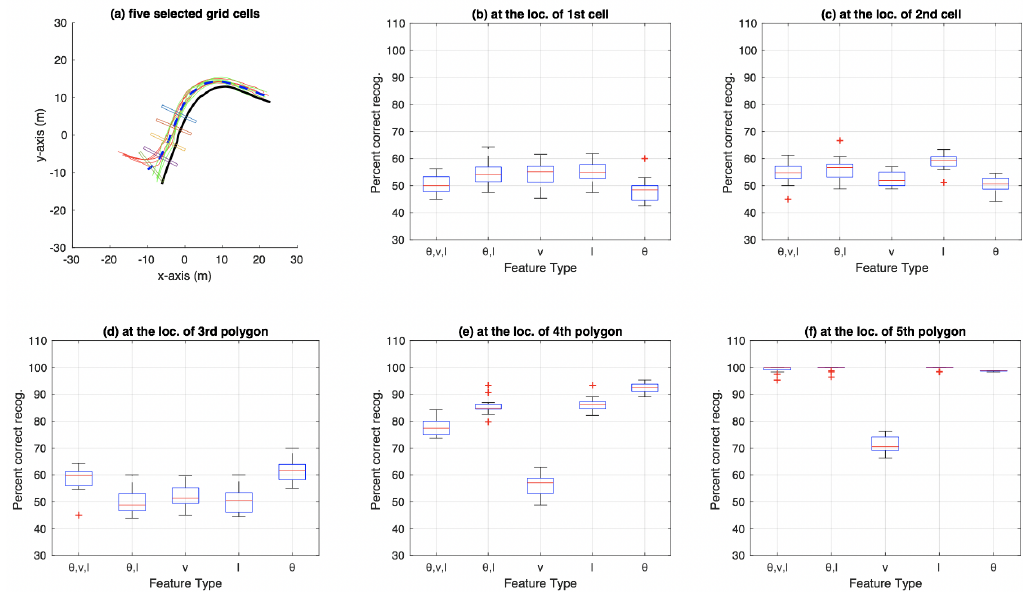
Figure 7. Aggregate results for bicycle dataset using particle filtering: ( a ) the five grid cells show locations where 60%, 70%, 80%, 90%, and 99% of the total bicycle path length (for the path discretised using the grid shown in Figure 1a) has been traversed; and ( b – f ) box plots at each of the five grid-cell locations in ( a ). Each subfigure ( b – f ) shows a box plot for percentage of correct category recognition for different feature types used including ( θ , v , l ) , ( θ , l ) , v , l and θ .